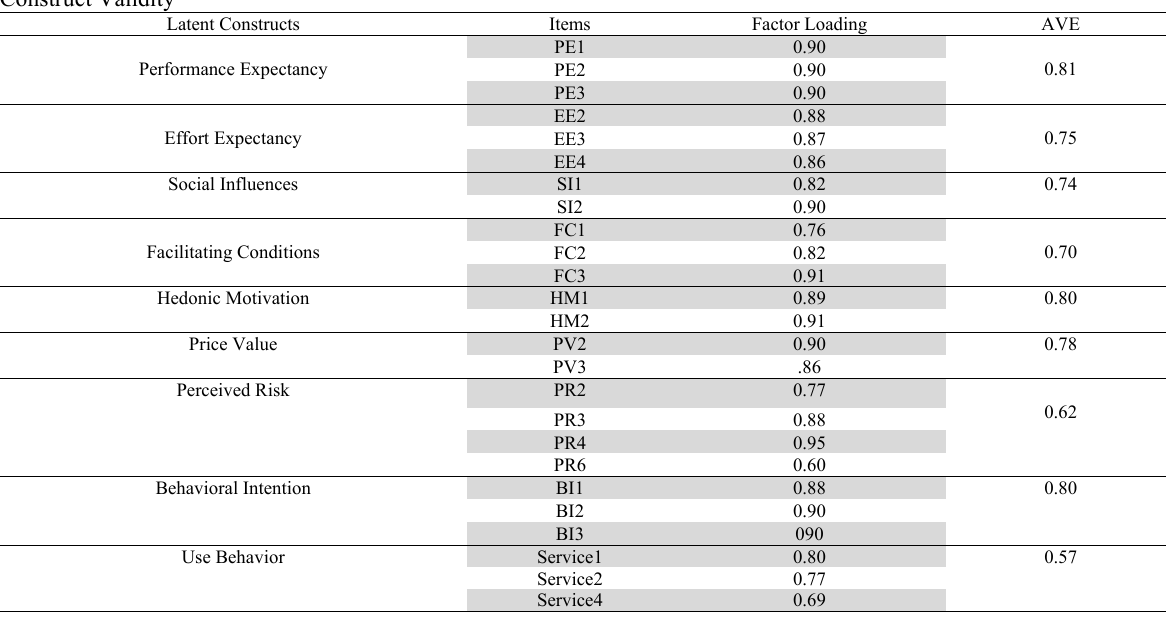
Construct Validity